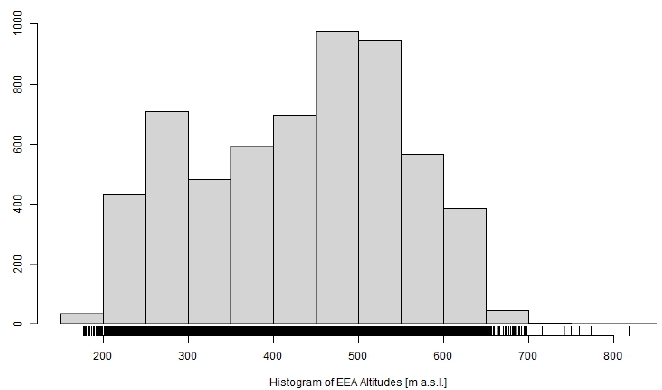
Figure 11. Distribution of EEAs by altitudes. Characteristics of horizontal axis are as follows: Min.: 177.0 m; Q1: 333.0 m; Median: 450.0 m; Mean: 432.9 m; Q3: 523.0 m; Max.: 818.0 m; SD: 119.8 m.